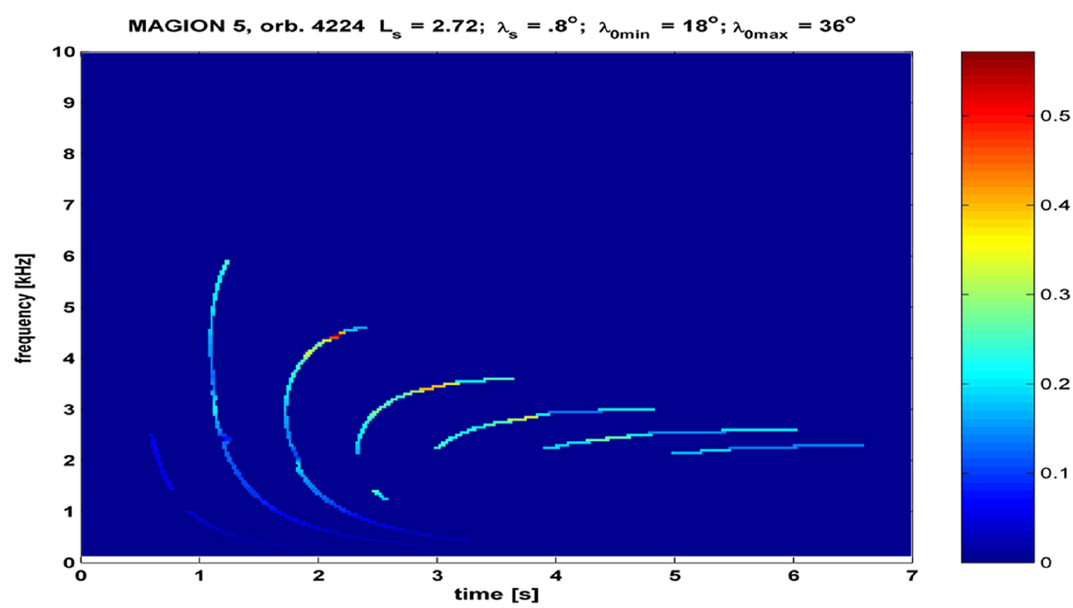
Fig. 7. Simulated spectrogram of MR whistler reproducing the real spectrogram taken by MAGION 5 on orbit 4224.